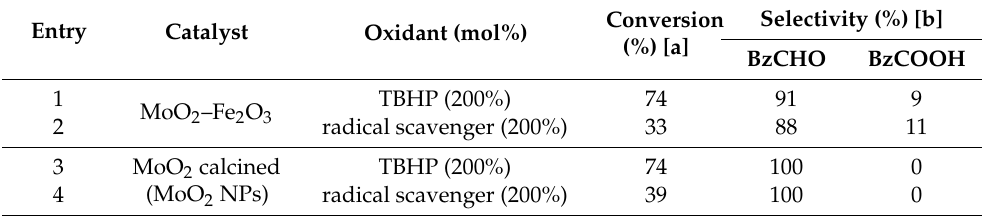
Table 2. Results from the benzyl alcohol oxidation with TBHP as the oxidant and a radical scavenger. Selectivity (%) [b] Conversion Entry Catalyst Oxidant (mol%) (%) [a] BzCHO BzCOOH 1 TBHP (200%) 74 91 9 MoO 2 –Fe 2 O 3 2 radical scavenger (200%) 33 88 11 TBHP (200%) 74 100 0 3 MoO 2 calcined (MoO 2 NPs) 4 radical scavenger (200%) 39 100 0 All reactions were carried out at 383 K in the presence of 200 mol% oxidant (TBHP), 4.32 mmol of alcohol, 0.56 mmol of the Mo nanocatalyst, and 1 mL decane; [a] Calculated after 24 h; [b] calculated as “Yield of product” / ”Conversion” × 100. From the above results, it could be rationalized that the radical